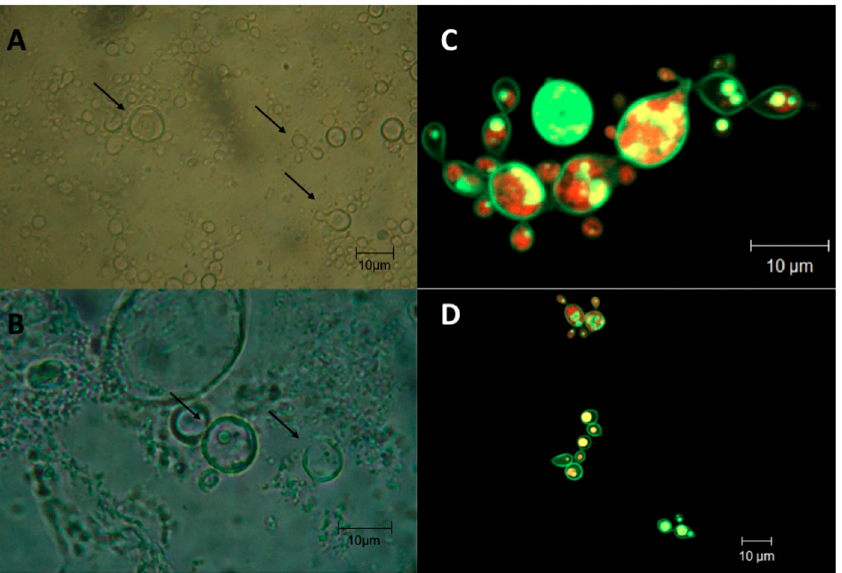
Figure 1. Morphological characteristics of Paracoccidioides sp. yeast cells recovered from direct optical microscopy exam ( A , B ) and confocal microscopy of the PlTO strain ( C , D ). Arrows indicate the presence of single or multibudding yeast